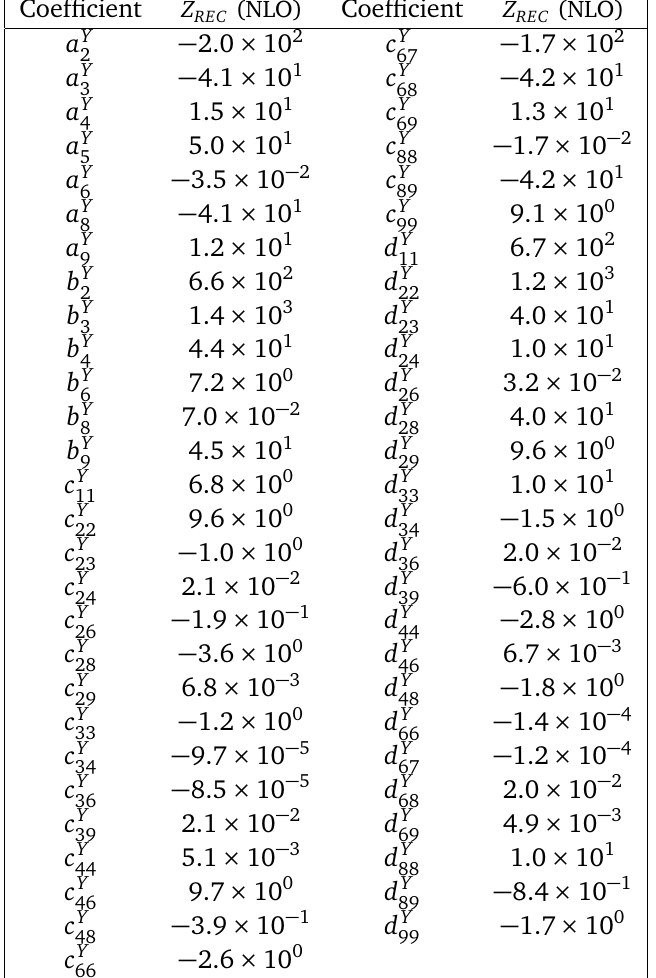
Table 7: Same as Tab. 5, now for the z momentum